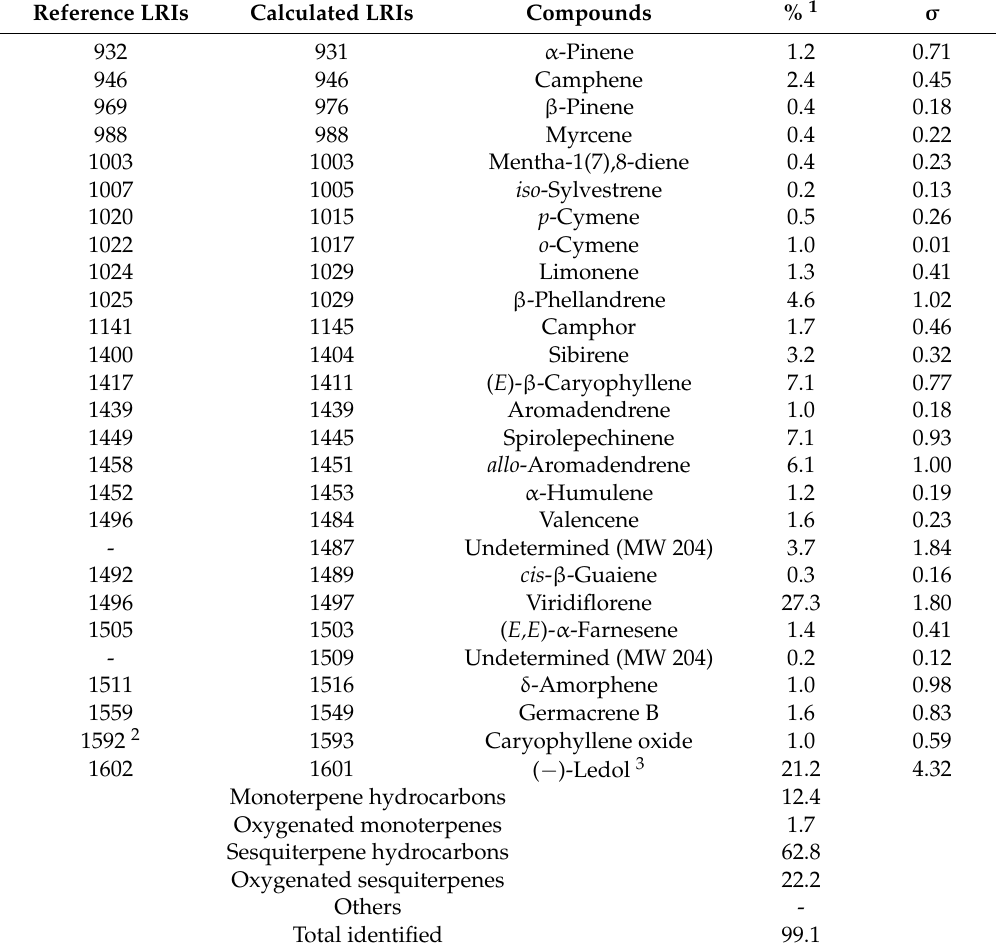
Table 1. Chemical analysis of L. heteromorpha essential oil (EO) on a DB-5ms